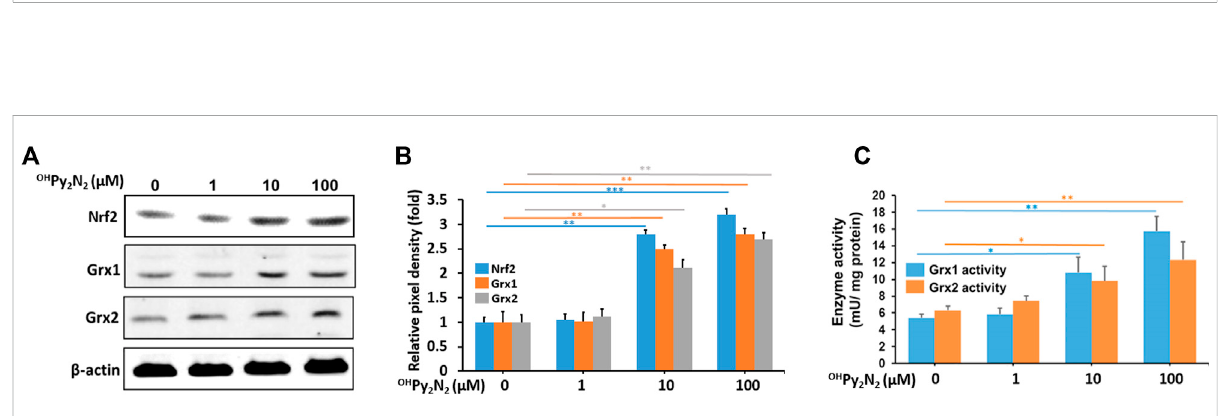
FIGURE 4 OH Py 2 N 2 upregulates Nrf2, Grx1, and Grx2 in LECs. (A) Western blot analysis showing the increased expression of antioxidant transcription factor Nrf2 along with enzymes Grx1, and Grx2. (B) The relative pixel density of Nrf2, Grx1, and Grx2 over loading control. (C) Grx1 and Grx2 enzymatic activity increased as a result of exposure to OH Py 2 N 2 . (* p < 0.05; ** p < 0.01; *** p < 0.001) ( n =